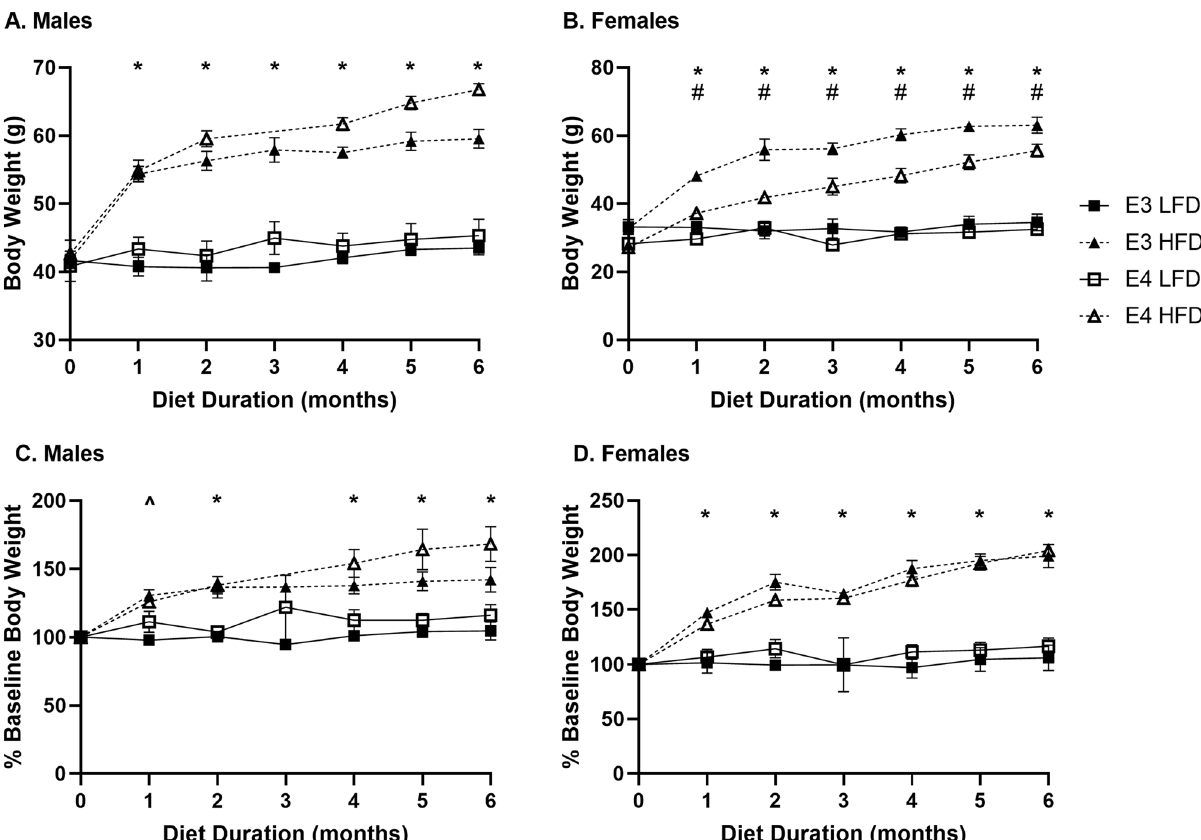
Figure 2. Body weight curves. ( A ) Male raw body weight (g) increases over 6 months of HFD compared to LFD. ( B ) E3 females on a HFD gain more body weight than E4 females on a HFD. ( C ) Male and ( D ) female body weights relative to the starting body weight are increased compared to baseline on due to a HFD. Two-way ANOVA: * p < 0.05 vs respective LFD group. # p < 0.05 vs genotype within diet. ^ p < 0.05 for only E3 HFD vs E3 LFD. n = Males: E3 LFD = 10, E3 HFD = 4–9, E4 LFD = 10, E4 HFD = 7–10; Females: E3 LFD = 9–10; all other female groups n =